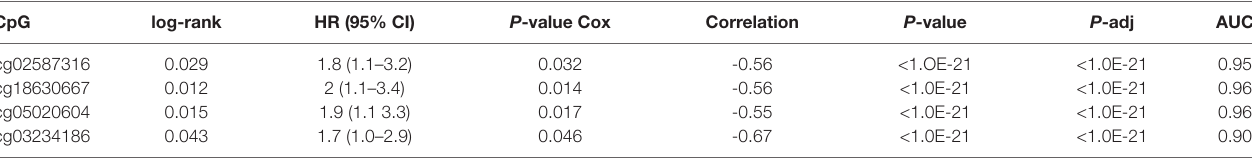
TABLE 5 | List of probable prognostic DNA methylation biomarkers for pancreatic ductal adenocarcinoma. CpG log-rank HR (95% CI) P -value Cox Correlation P -value P